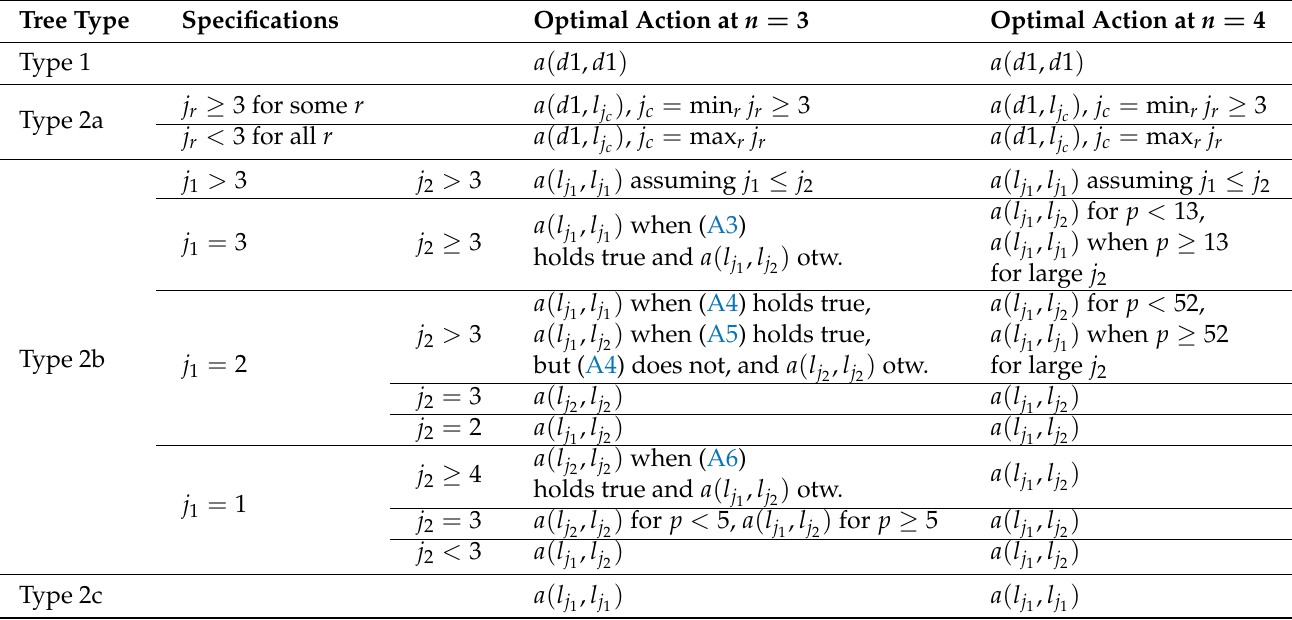
Table A2. Comparison of optimal actions at n = 3 and n =